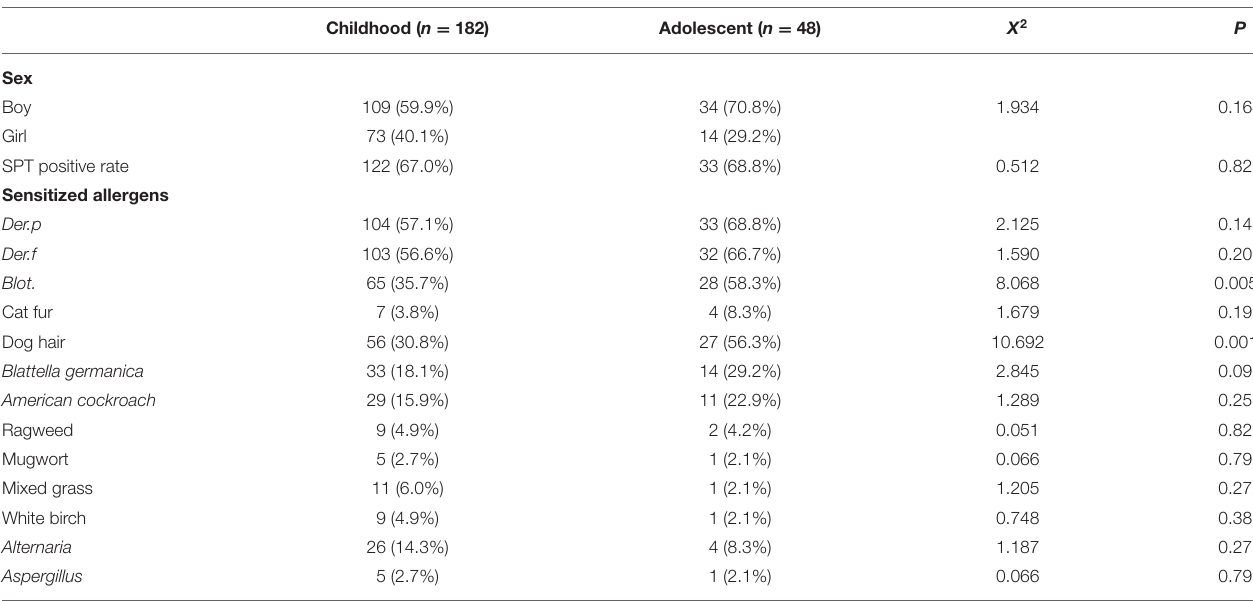
TABLE 1 | Comparison of sensitized allergens among different